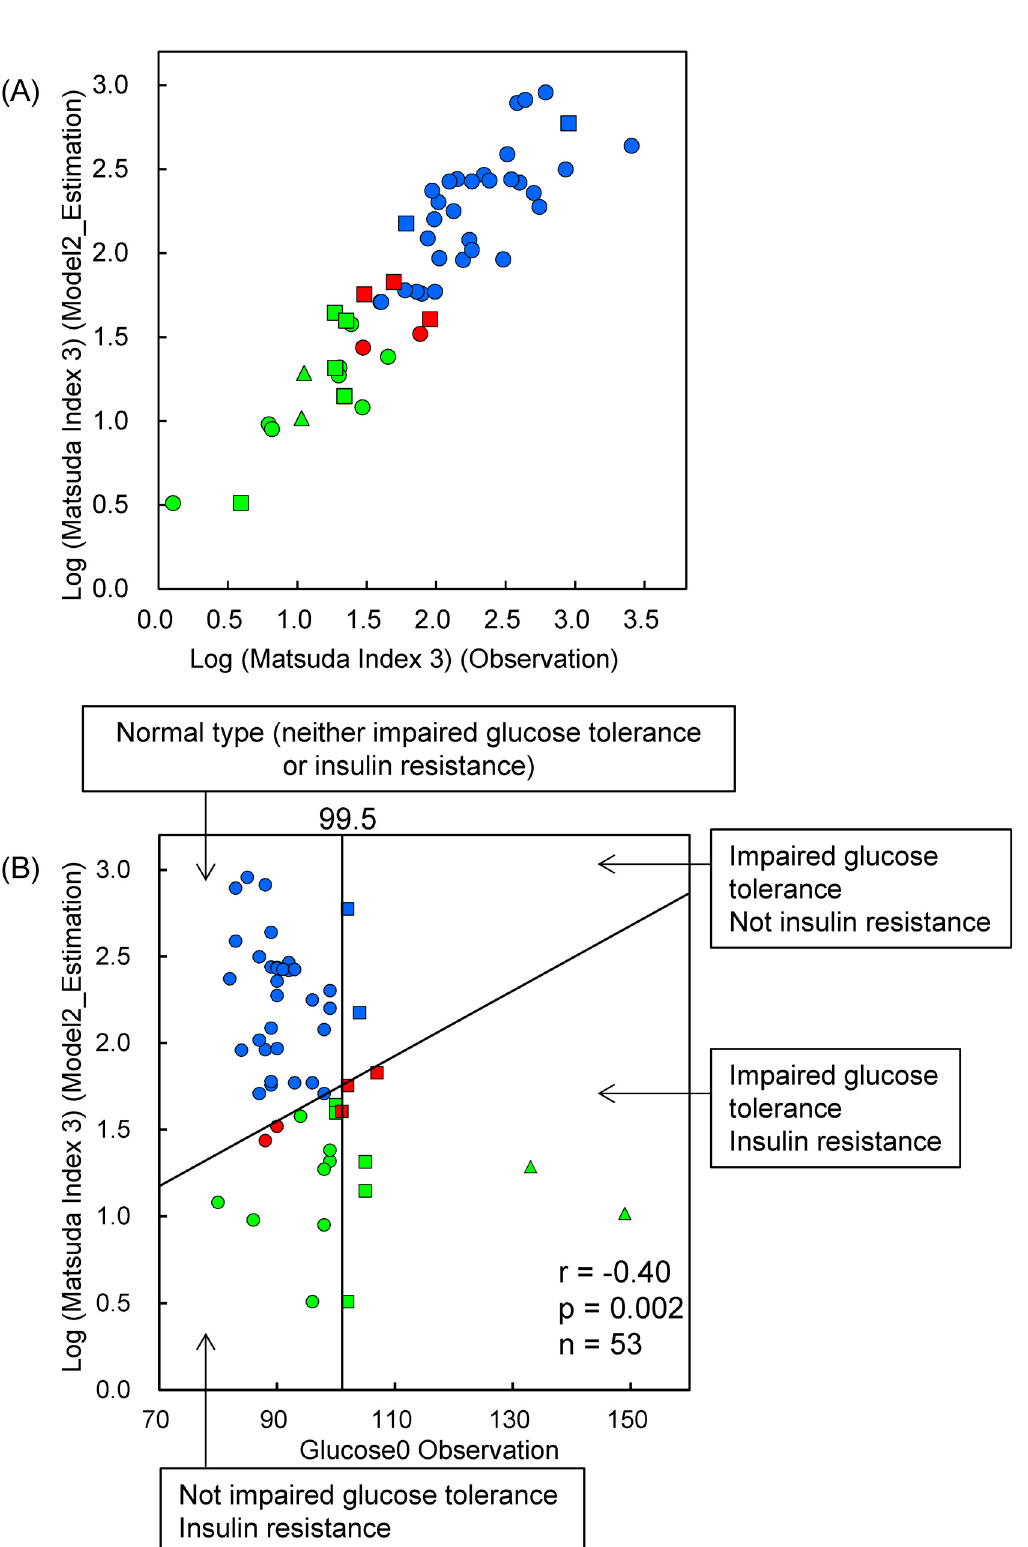
Fig 6. Selecting biomarkers for practical use. Matsuda Index 3 is estimated using 10- and 12- (Z , E) -hydroxyoctadecadienoic acid, insulin, and leptin/ adiponectin (Model 2) (A), and the risk of glucose tolerance and insulin resistance is predicted using fasting levels of glucose and estimated Matsuda Index